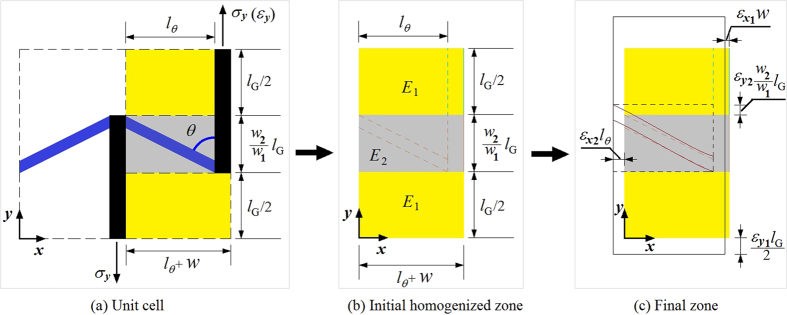
A part of the microstructure shown in Fig. 1b. The right half part of (a) is a quarter of the unit cell. The sizes are labelled. The grey area represents the domain whose mechanical property is determined by the oblique bar and the vertical bar. The mechanical property of the yellow area is determined by the vertical bar. (b) The homogenized model38 of the right half part of (a). E1 and E2 (<E1) are the in-plane equivalent moduli of the yellow and grey areas, respectively. (c) The final deformation.